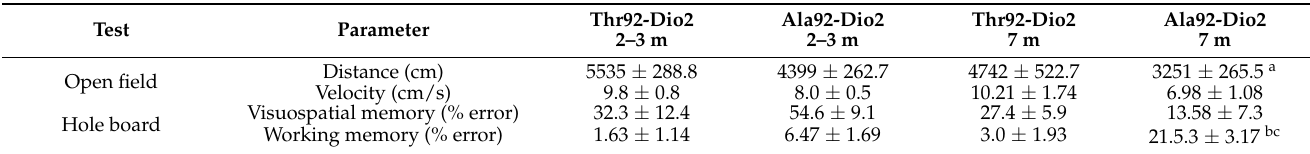
Table 1. Cognitive and behavioral phenotype of 2–3-month-old and 7-old-month male Ala92-Dio2 mice.